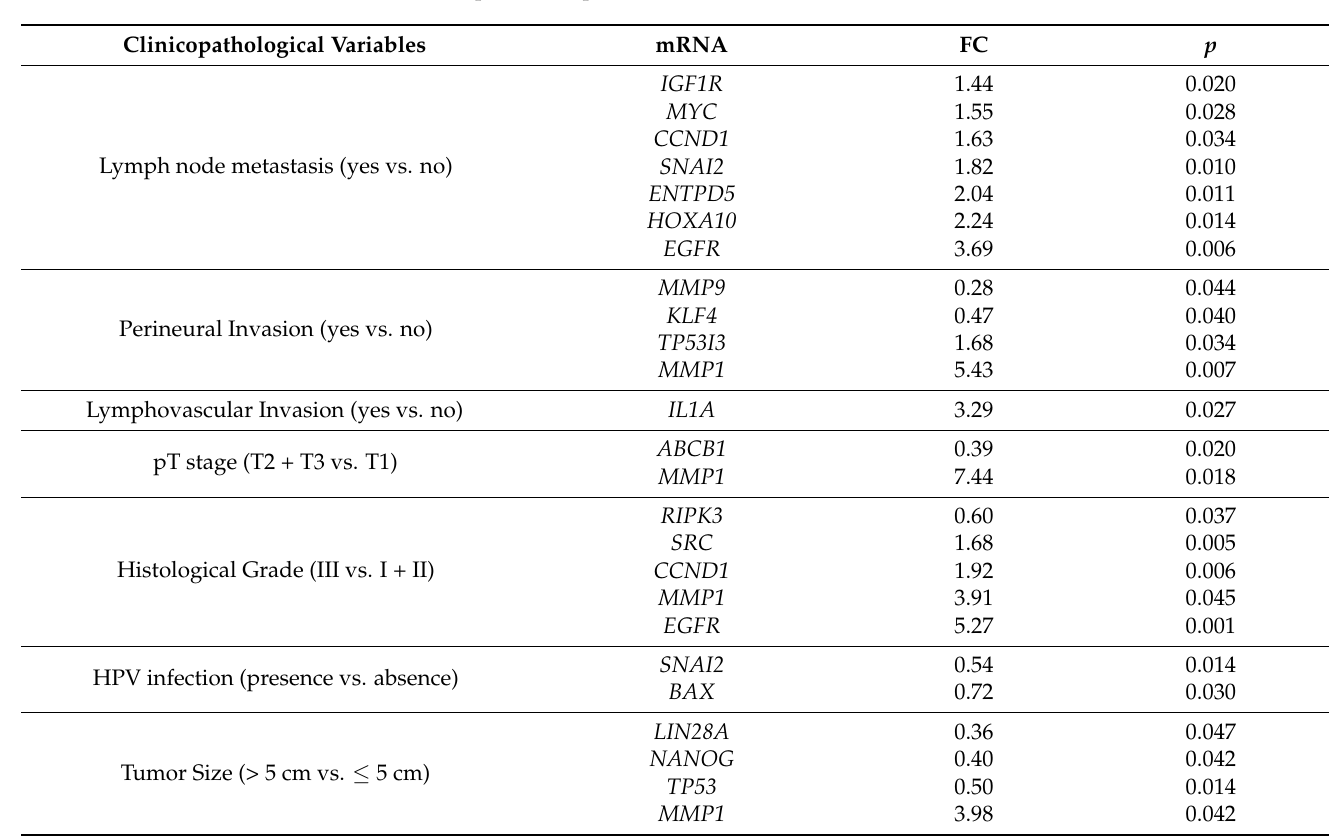
Table 3. Significant associations between gene expression levels and clinicopathological variables in the total sample of PeC patients ( n =